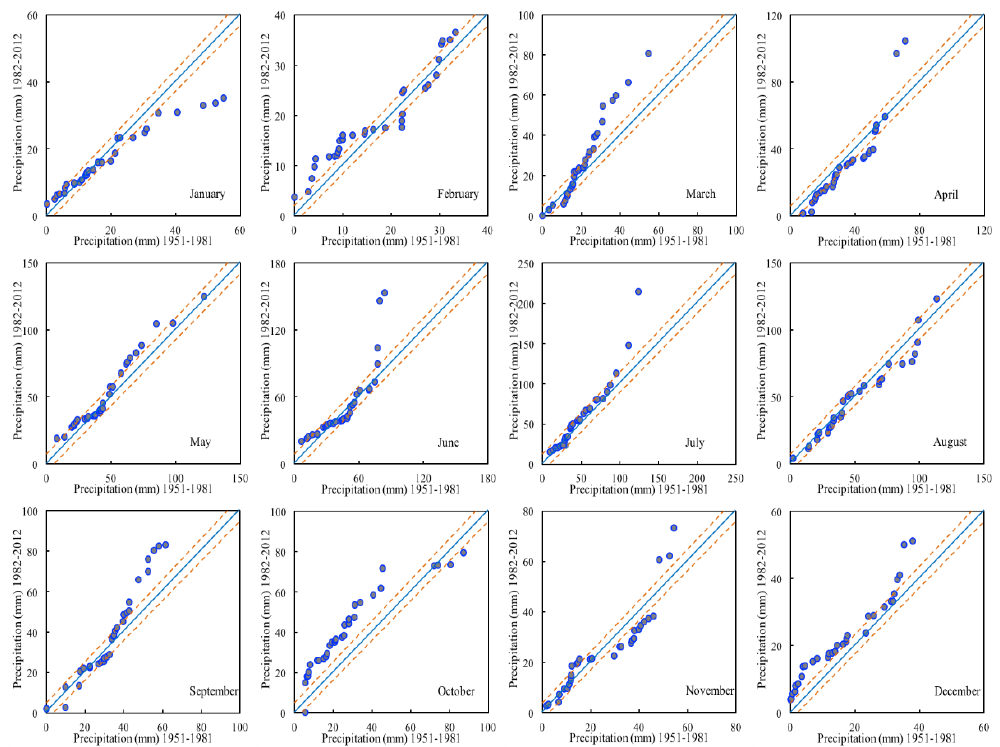
Figure 5. The results of applying the ITA method for monthly precipitation at the Kyzyl-Suu station in the Lake Issyk-Kul basin 1951–2012.